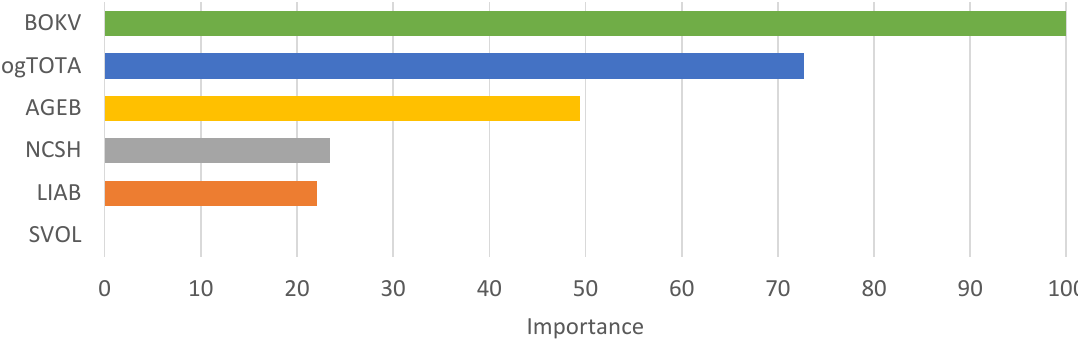
Figure 6. Pruned regression tree variable importance scores for EPS model